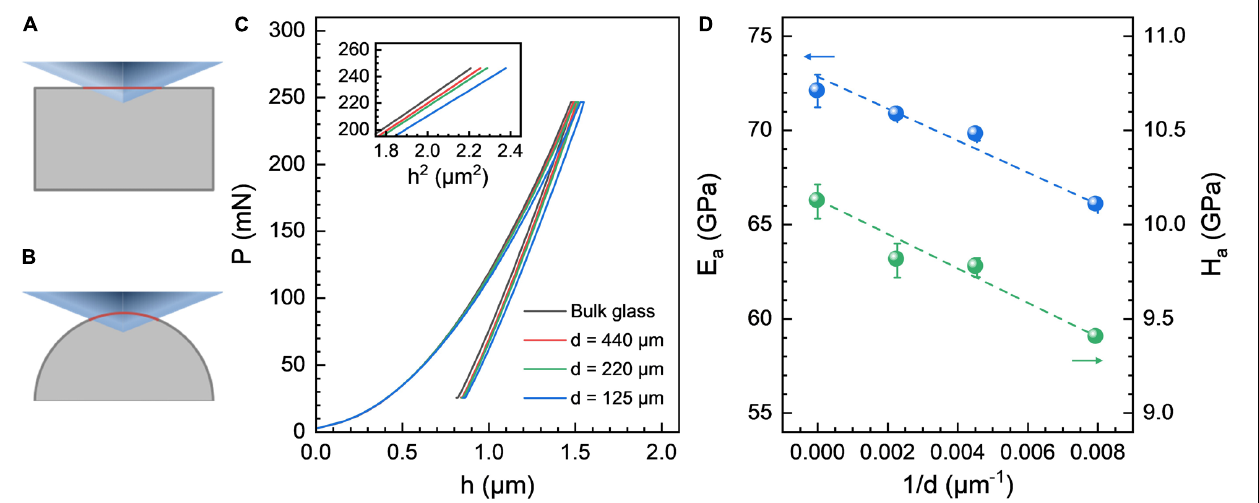
FIGURE 2 | (A) Schematic illustration of the contact behavior between a Vickers tip and (A) flat or (B) curved glass surfaces. The contact areas projected on the original surfaces are marked in red. (C) Representative load-displacement P - h curves as recorded from nanoindentation experiments on bulk vitreous silica and silica glass fibers of varying diameter d using a Vickers tip. The inset displays P as a function of h 2 . (D) Apparent Young’s modulus E a and hardness H a as a function of fiber diameter.